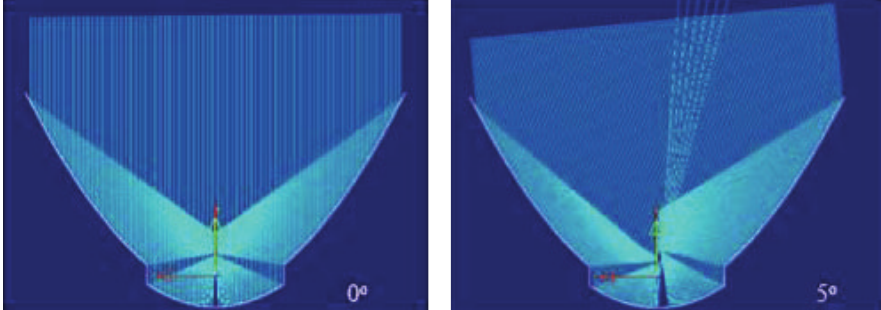
Figure 3: Light tracing analysis of the concentrator.